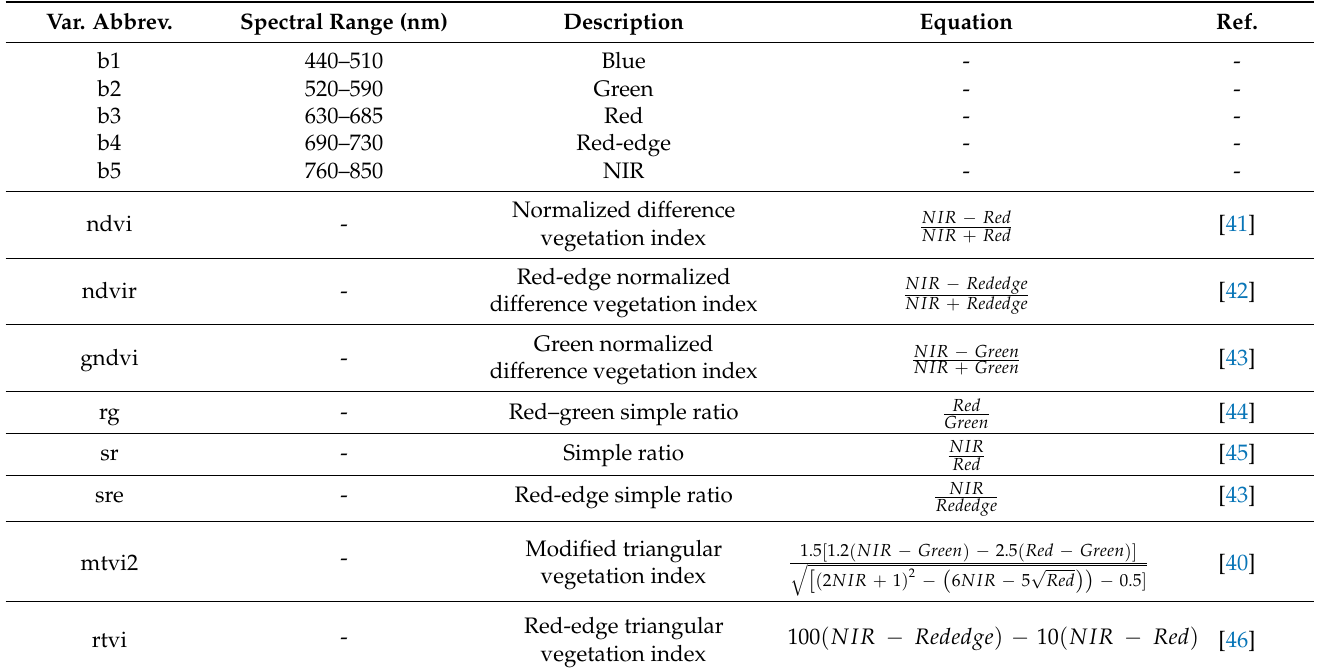
Table 1. Spectral bands and VI from RapidEye leaf-on and leaf-off satellite imagery used as predictor variables in ensemble models of α -diversity measures.